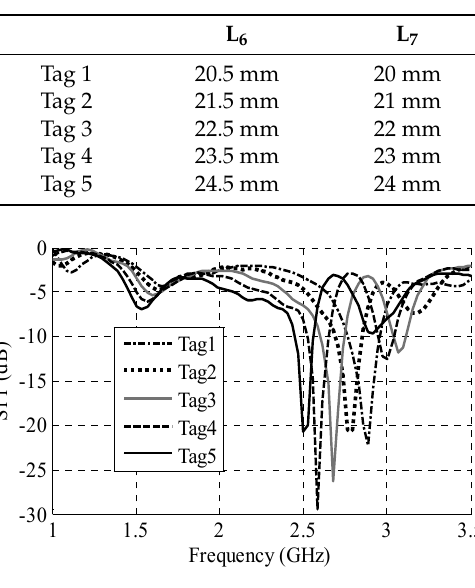
Figure 4. Antenna response for unique identification.